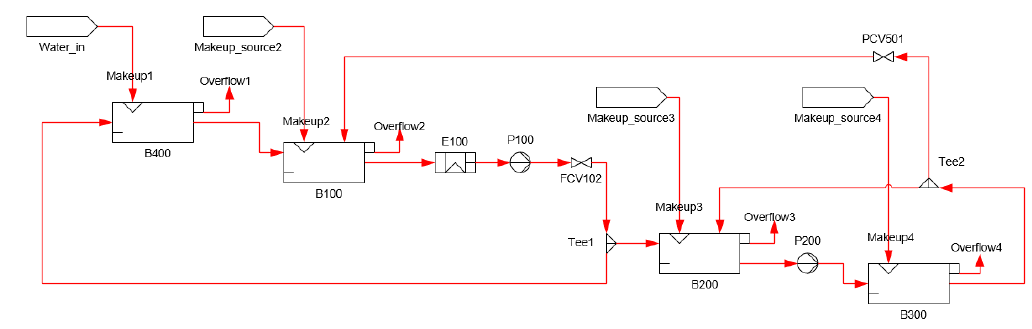
Figure 14. Imported flowsheet of the steady state model.